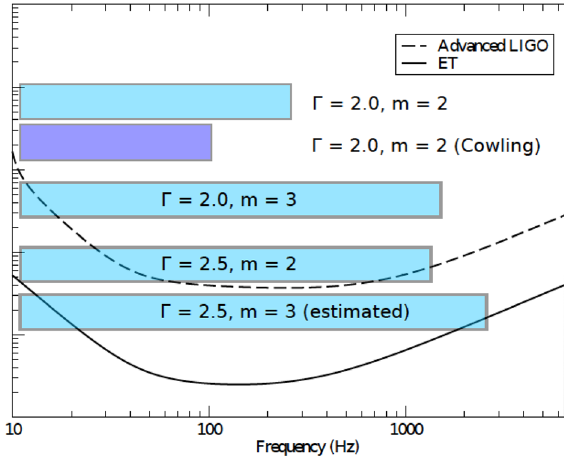
Fig. 29 Frequency band of the CFS instability based on m = 2 and m = 3 f -mode oscillations for two sequences of rigidly rotating polytropic neutron stars with Γ = 2 and Γ = 2 . 5. Each band is limited on the left by the neutral point and on the right by the frequency of the counter-rotating mode in the most rapidly rotating model. The sensitivity noise curves of aLIGO and the future Einstein Telescope are also plotted. (Image reproduced with permission from Zink et al. 2010, copyright by